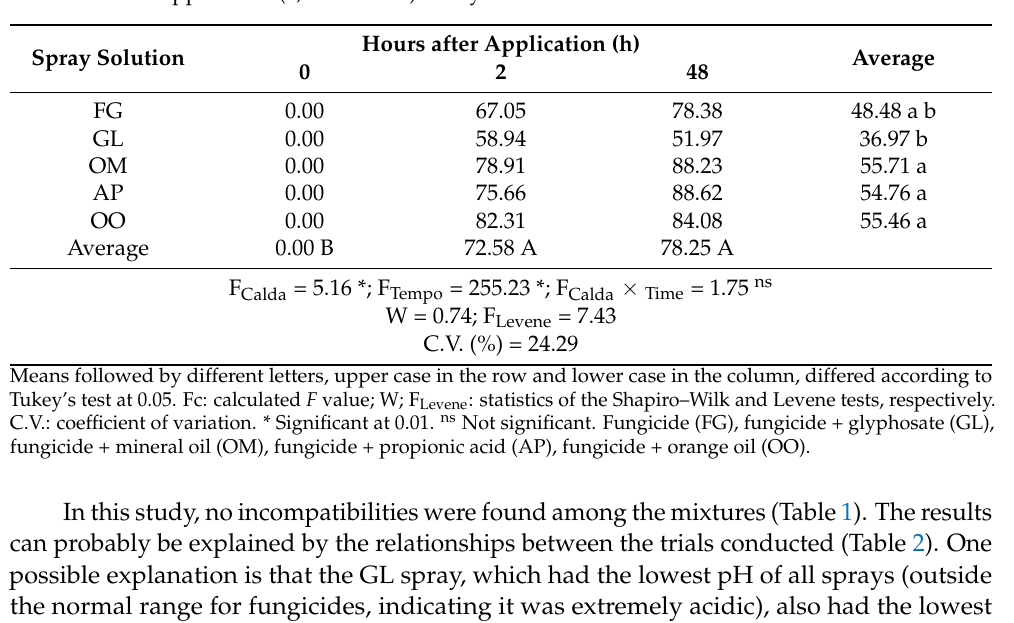
Table 4. Absorption of azoxystrobin (%), applied alone or with glyphosate or adjuvants, evaluated over time after application (0, 2 and 48 h) in soybean